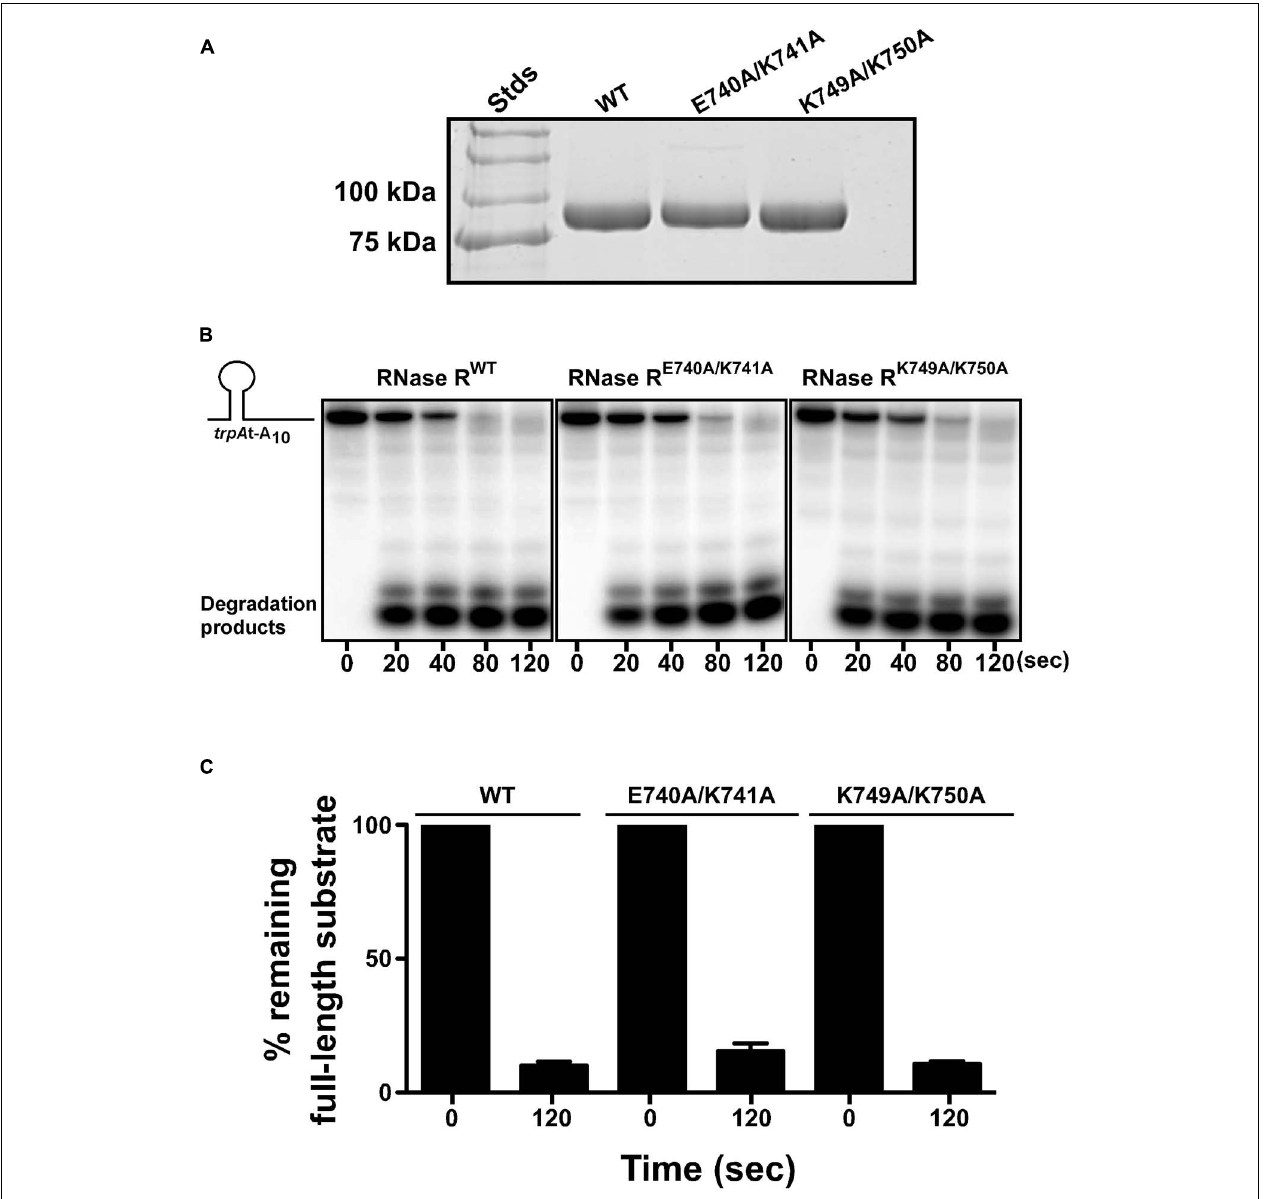
FIGURE 5 | RNase R variants degrade RNA substrates in vitro . (A) Coomassie stained protein gel showing purified RNase R variants. RNase R and its variants (RNase R E740A / K741A and RNase R K749A / K750A ) were purified from an rnr − rnb − strain, resolved by electrophoresis on a 10% SDS-polyacrylamide gel, and stained with Coomassie Brilliant blue. (B) Representative autoradiographs showing the degradation of trp At-A 10 RNA substrate by indicated RNase R variants. The 32 P-labeled RNA substrate was used to test the degradation